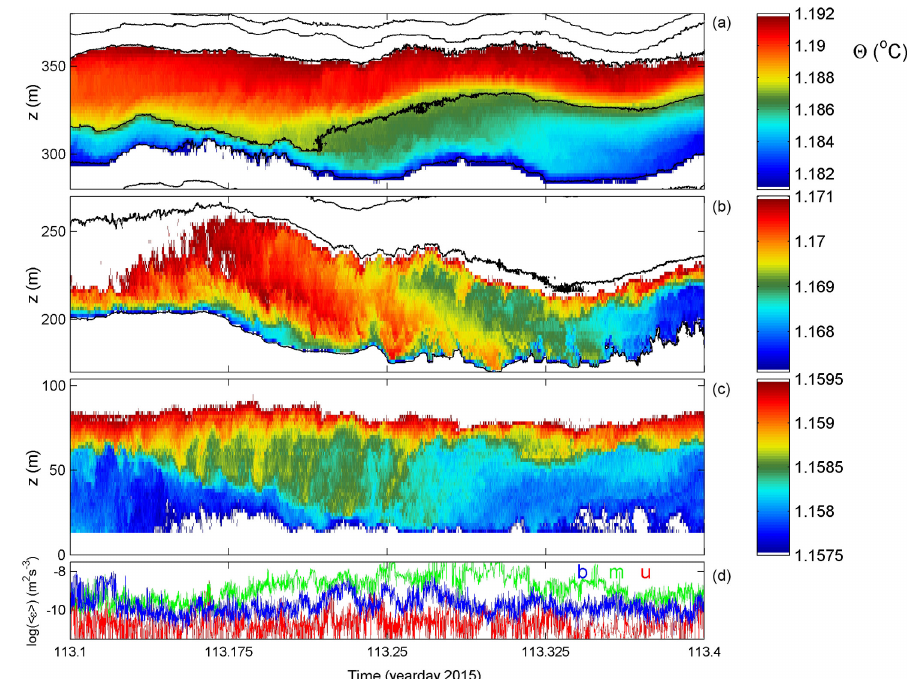
Figure 8. As Fig. 4, but associated with Fig. 7 and using different colour